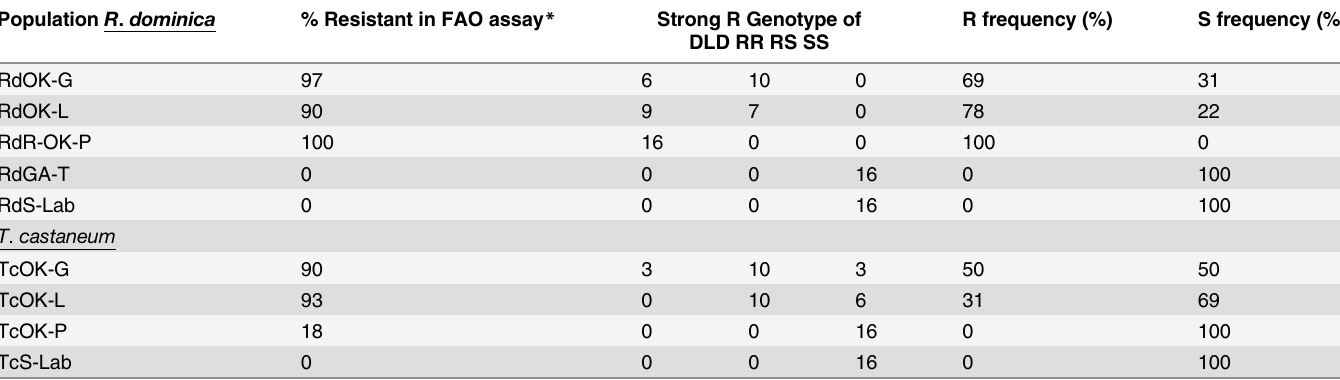
Table 1. Genotype frequencies derived from CAPS marker analysis in R . dominica (Rd) and T . castaneum (Tc) populations. Population R .